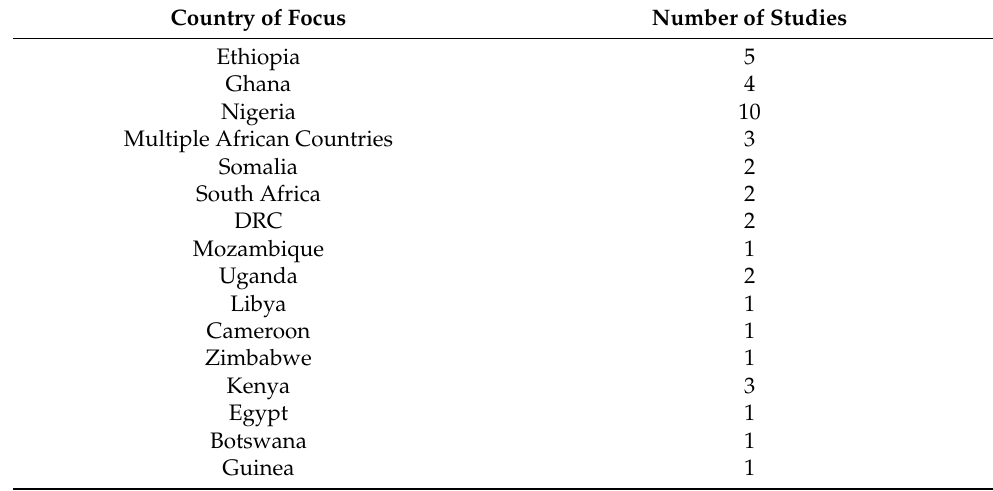
Table 1. Illustrates—the number of countries reviewed. Country of Focus Number of Studies